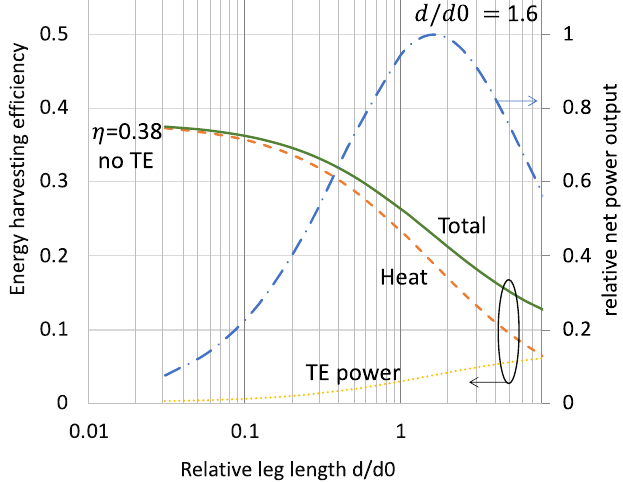
Figure 6. Energy harvesting efficiency from the thermoelectric integrated heat exchanger. The opti- mum design for the thermoelectric leg length d is 1.6 times longer than the optimum d 0 for constant temperature boundary conditions. All data points are the results for the matched heat capacity condition between the hot gas and cold water ( 𝐶 (cid:3034) = 𝐶 (cid:3050) ) , where m g = 0.21 kg/s and m w = 0.05 kg/s; both are for per unit area (1 m 2 ) of the footprint of the thermoelectric integrated heat exchanger. A longer leg design provides a large temperature gradient across the thermoelectric legs, which increases the electrical power output and drastically decreases the heat harvesting due to the low thermoelectric conversion efficiency.